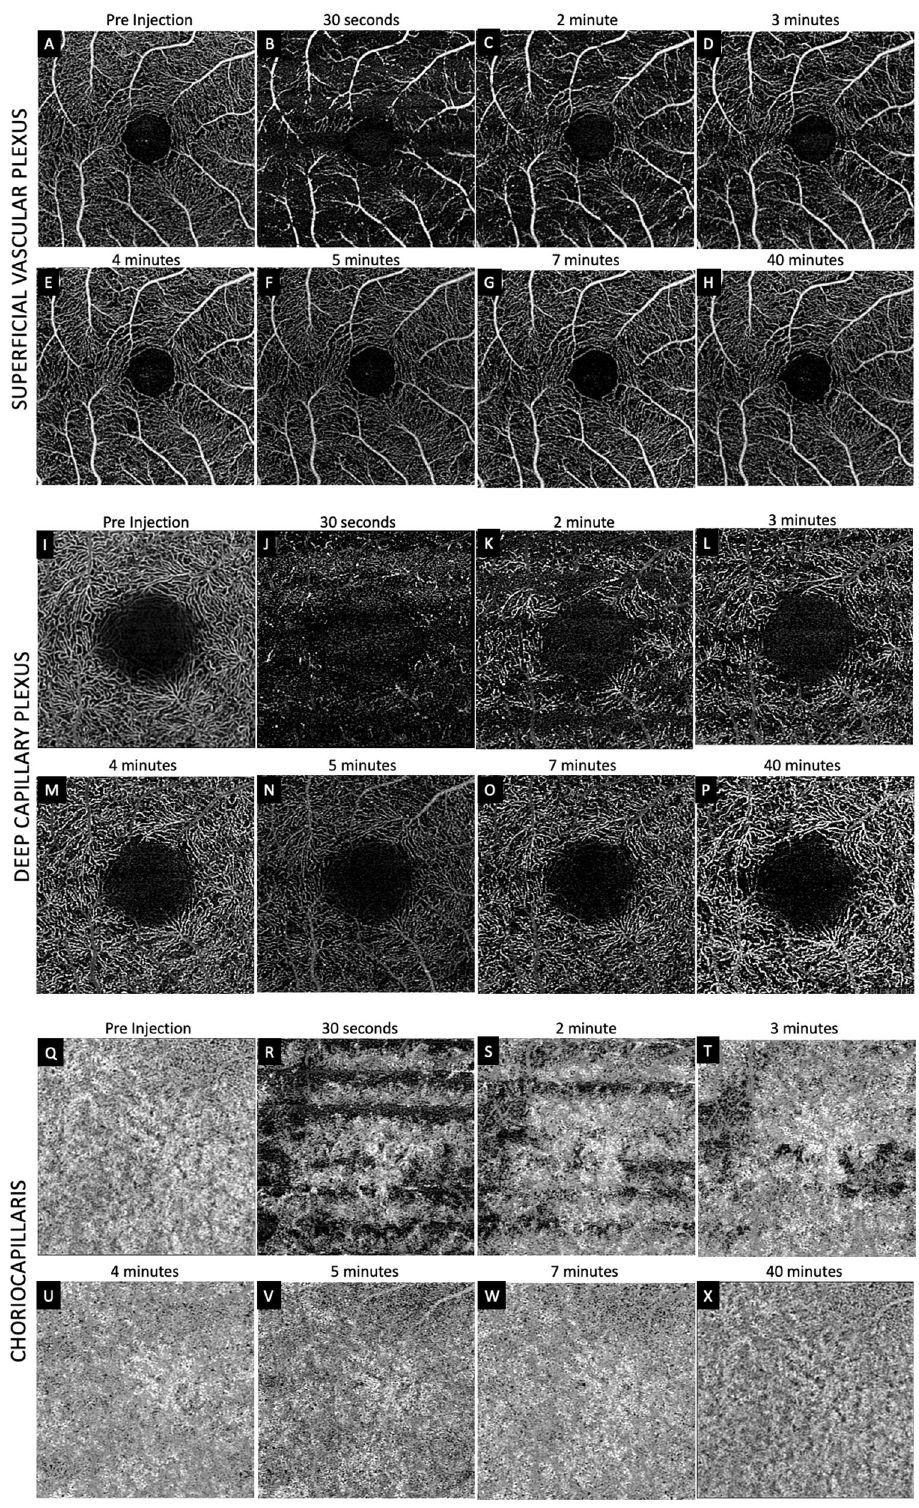
Figure 1. Sequential optical coherence tomography angiography (OCTA) Monkey 1. ( A–H ) shows superficial vascular plexus (SVP), deep capillary plexus (DCP) and choriocapillaris (CC) layers. Panel ( A ), ( I ) and ( Q ) show pre-injection OCTA of SVP, DCP and CC respectively. At 30 s post injection, when intra ocular pressure (IOP) was 98 mmHg, flow was only noted in main arterioles and veins with minimal detection of flow signal within the capillary beds in the SVP ( B ). At the same time, there was marked reduction in flow signal in the DCP ( J ) and in the CC ( R ). Dark horizontal bands are observed in all three layers. Progressively more flow signal was noted over time in the SVP ( C – G ), DCP ( K – O ) and CC ( S – W ). By 7 min, when IOP was 22 mmHg. As flow signal increased in the DCP, recognizable capillary units arranged around an epicenter could be appreciated ( L – O ), despite persistence of patchy areas of flow deficit. In the CC, areas of flow deficit progressively decreased ( R – U ). By 40 min ( H , P and X ) the flow distribution in the SVP and CC resembled the respective pre-injection images, but flow deficits in the DCP were more evident when compared to the pre injection